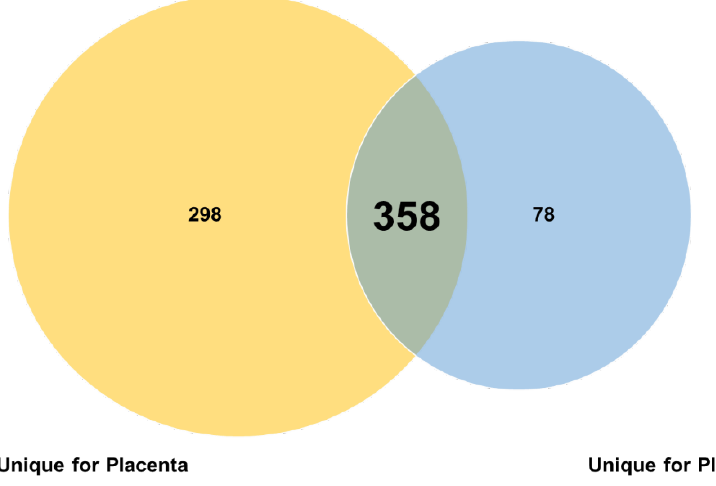
Figure 1. Venn diagram of overlapping and specific miRNAs in plasma and placenta.